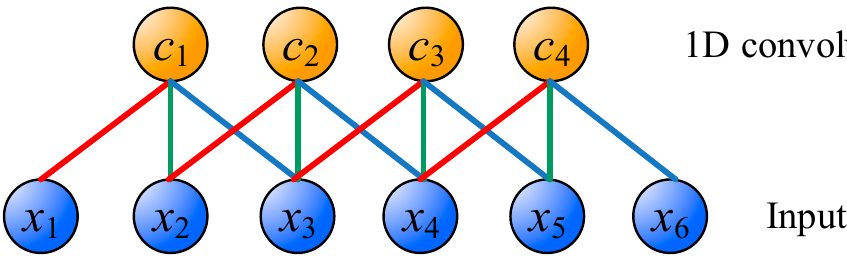
Figure 3. The one-dimensional (1D) convolution operation.